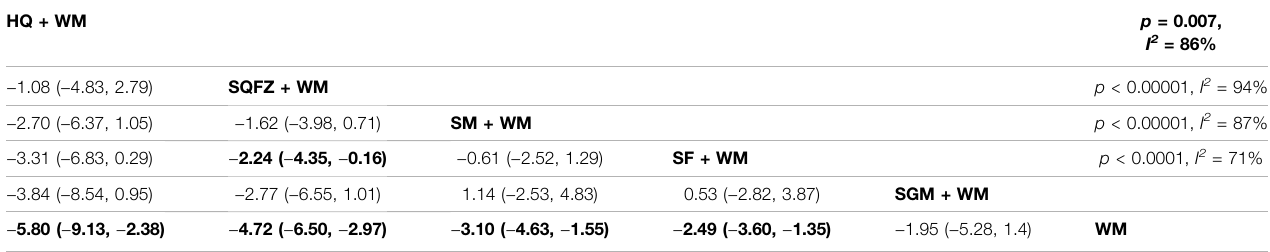
TABLE 2 | MDs with 95% CIs of APACHE II score. Signi fi cant effects are printed in bold. HQ + WM